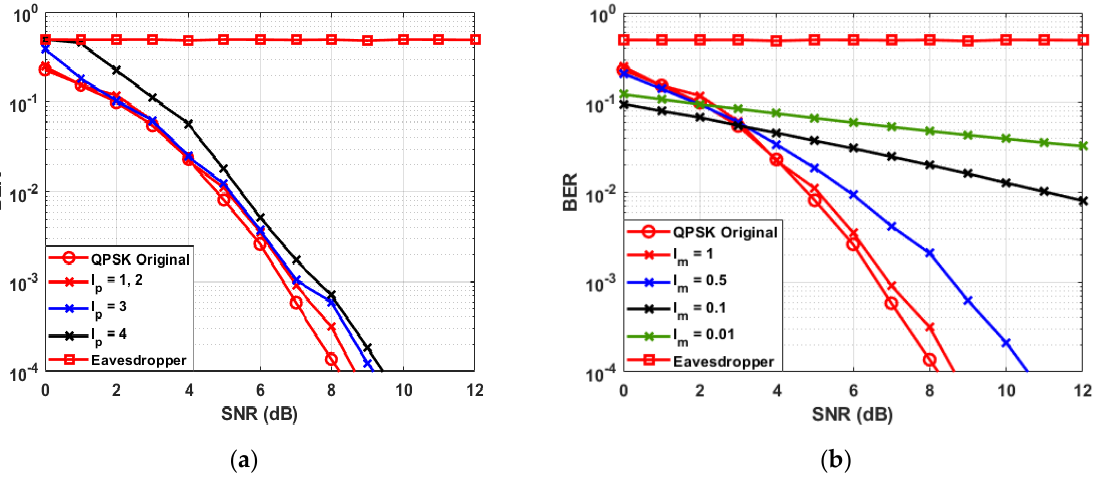
Figure 14. Performance evaluations with varying ( a ) magnitude-modifying factors ( I m ) and ( b ) phase-modifying factors ( I p